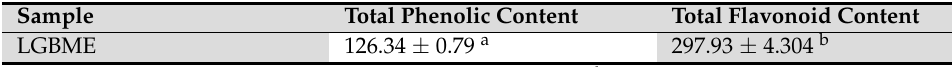
Table 1. Quantitative phytochemical analysis of LGBME.